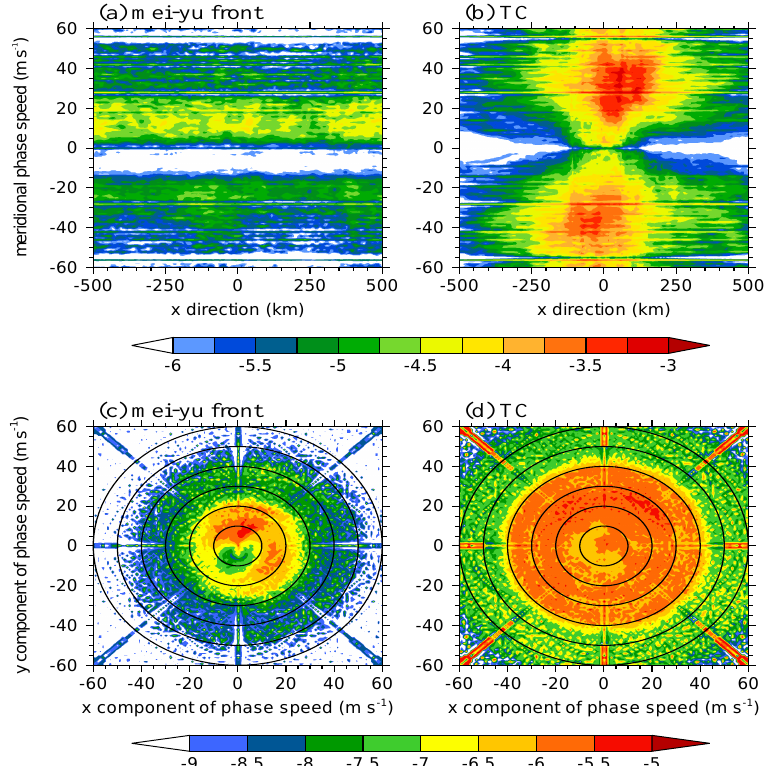
Figure 5. Base-10 logarithm of PSDs of w GW (shaded; m 2 s –2 ) as a function of ( a , b ) x direction and meridional phase speed, and ( c , d ) zonal and meridional component of horizontal phase speed at z = 17 km for ( a , c ) the mei-yu front and ( b , d ) the TC. The black rings in the bottom panels show the magnitude of horizontal phase speed at each 10 m s − 1